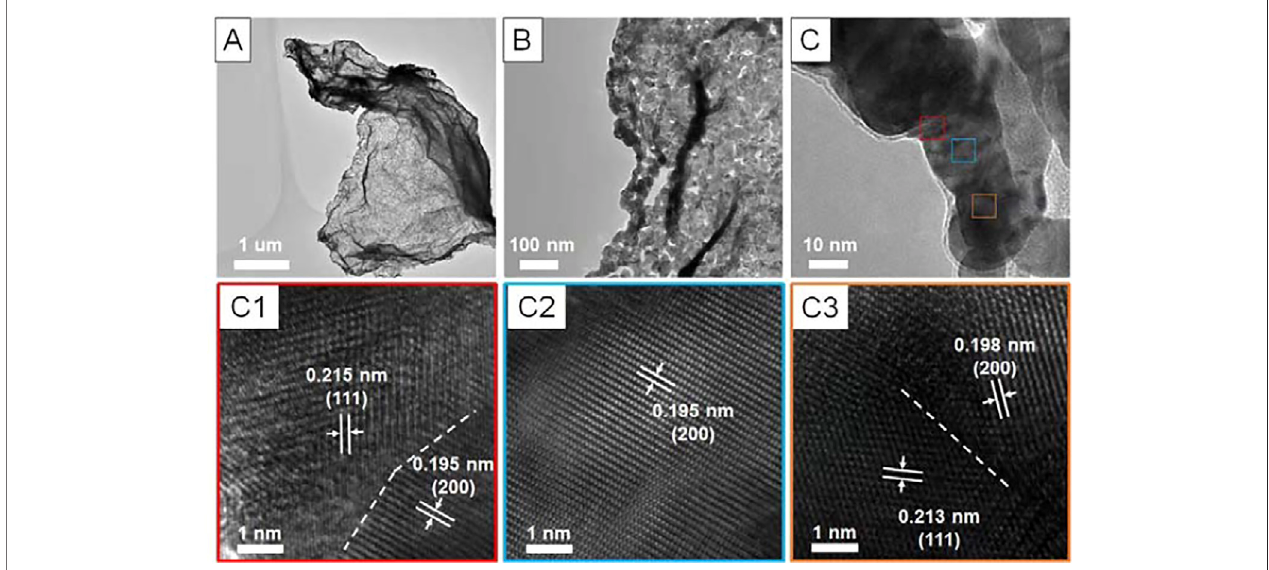
FIGURE2| SpectroscopycharacterizationsofPtPNSs. (A) XRDpattern, (B) XPSPt4fspectrum, (C) XANESspectra,and (D) Fourier-transformed-extendedX-ray absorption fi ne structure (FT-EXAFS) curves.